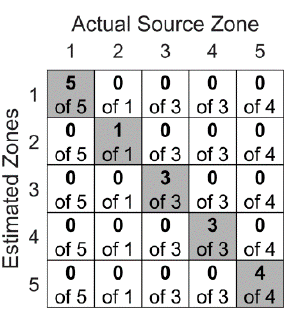
Figure 12. The confusion matrix of the stacked autoencoders in zonal localization of the first experimental scenario. Localization zone here is the closest rivet to the AE source.